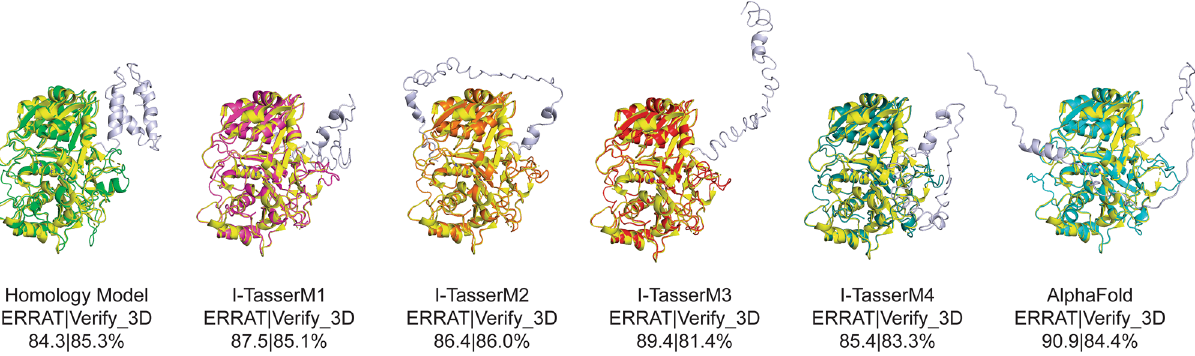
Figure 6. Predicted structural conformations of yeast Tdp1 N-terminal domain. The structure of the yeast Tdp1 NTD was predicted using homology modeling (Phyre2-server [http:// www. sbg. bio. ic. ac. uk/ ~phyre2/ html/ page. cgi? id= index] followed by molecular modeling using MOE and AMBER99), AlphaFold (https:// alpha fold. ebi. ac. uk/) and I-Tasser (https:// zhang group. org/I- TASSER/). Shown prediction models are overlayed on the yellow-colored yeast wild-type crystal structure of the catalytic core domain (missing NTD amino acid 1–79) PDB-1Q32 8 . All shown prediction models passed quality control of UCLA SAVESv6.0 server based on ERRAT- overall quality factor (statistics of non-bonded interactions) and a verify_3D score (compatibility of atomic model with its own aa sequence). All structure cartoons were generated using PyMol 2.5.2 (Molecular Graphics System, Schrödinger,